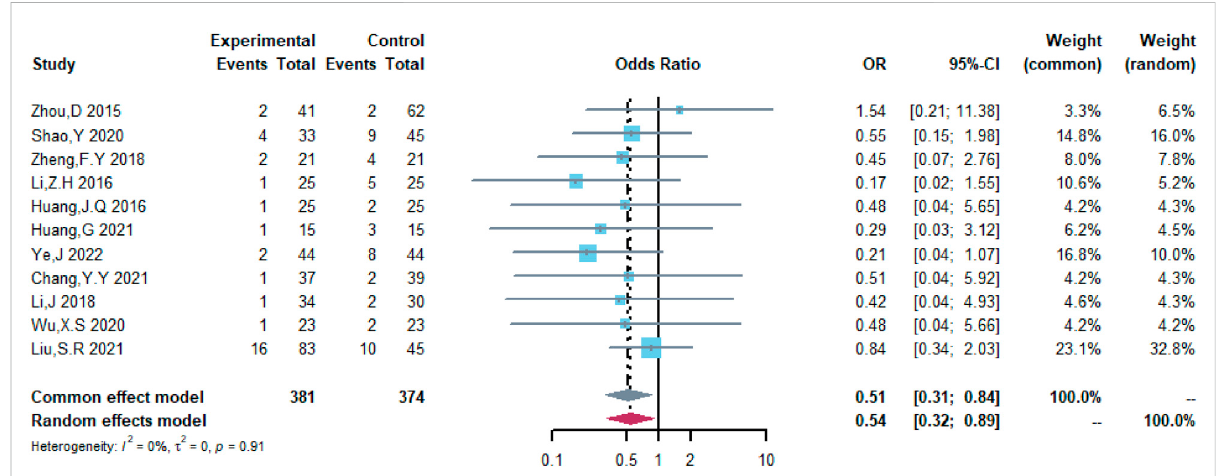
FIGURE 16 Analysis of progressive disease (PD) in (R)-CDOP vs. (R)-CHOP